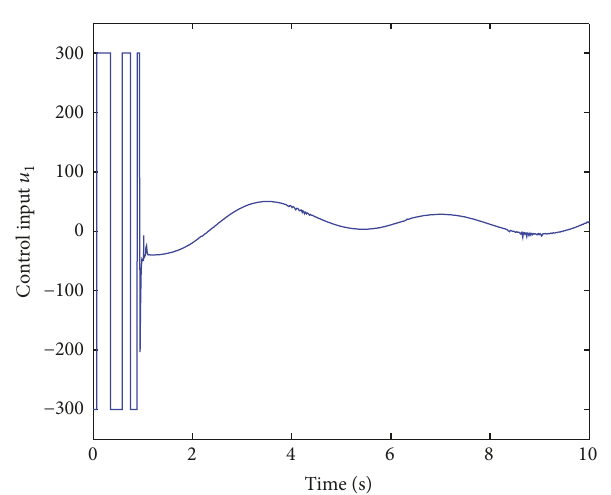
Figure 8: Response of the control input 𝑢 1 .